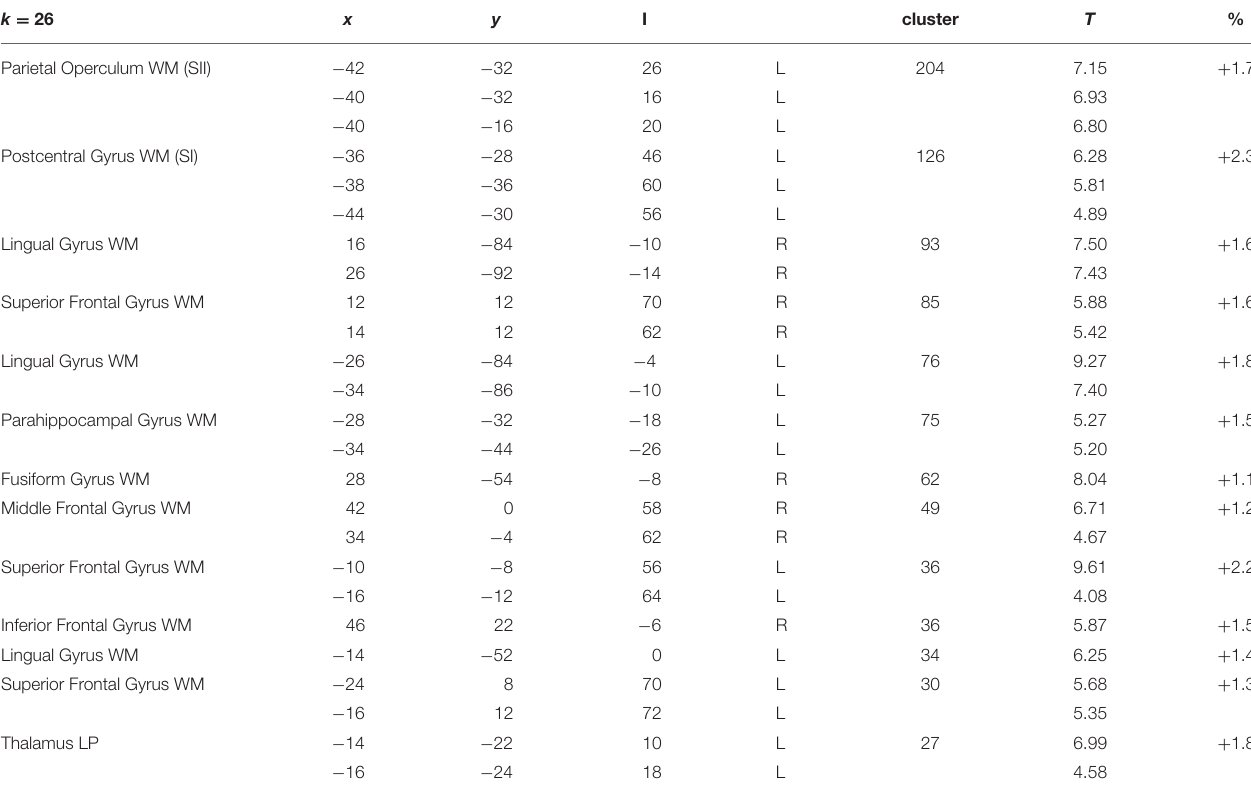
TABLE 2 | Changes in FA maps after Braille training. k =